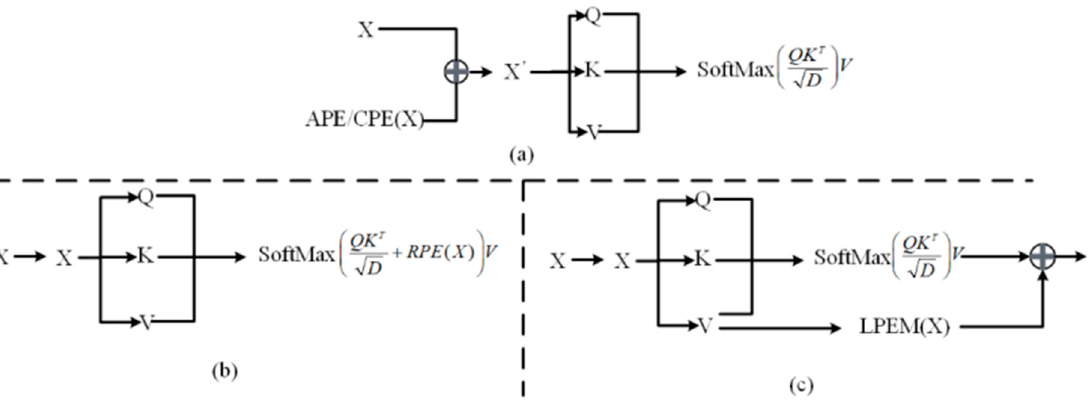
Figure 5. Comparison between different positional enhanced mechanisms: ( a ) APE and CPE ( b ) RPE ( c ) LPEM.